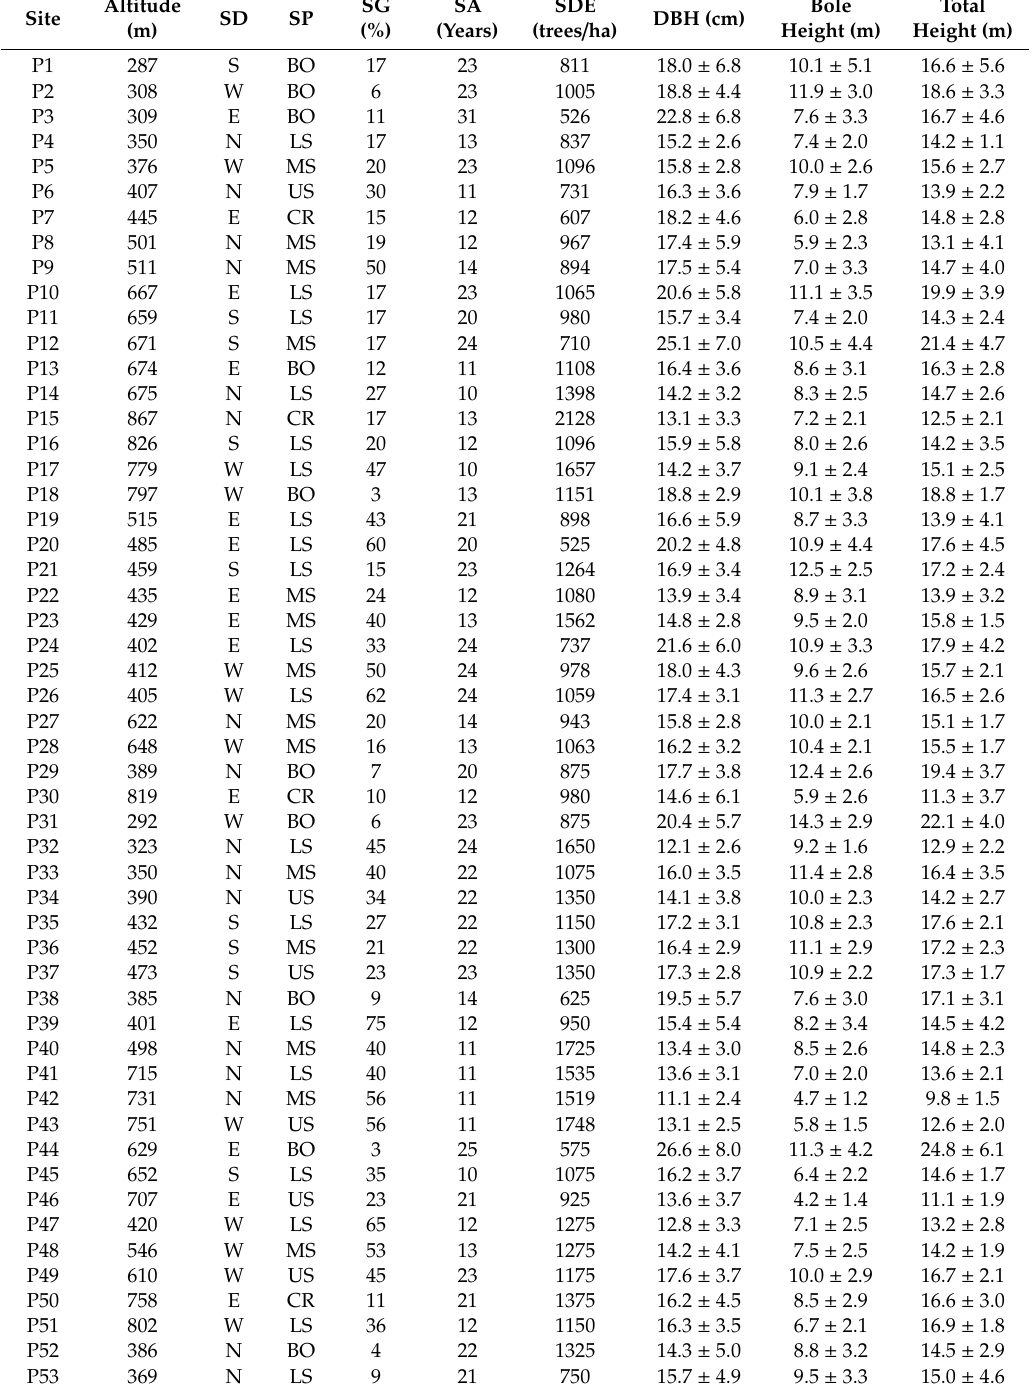
Table A1. Characteristics of selected plots and sample trees. Slope direction (SD); north (N); east (E); south (S); west (W). Slope position (SP); bottom (BO); lower slope (LS); middle slope (MS); upper slope (US); crest (CR). Slope gradient (SG). Stand age (SA). Stand density (SDE). Diameter at breast height